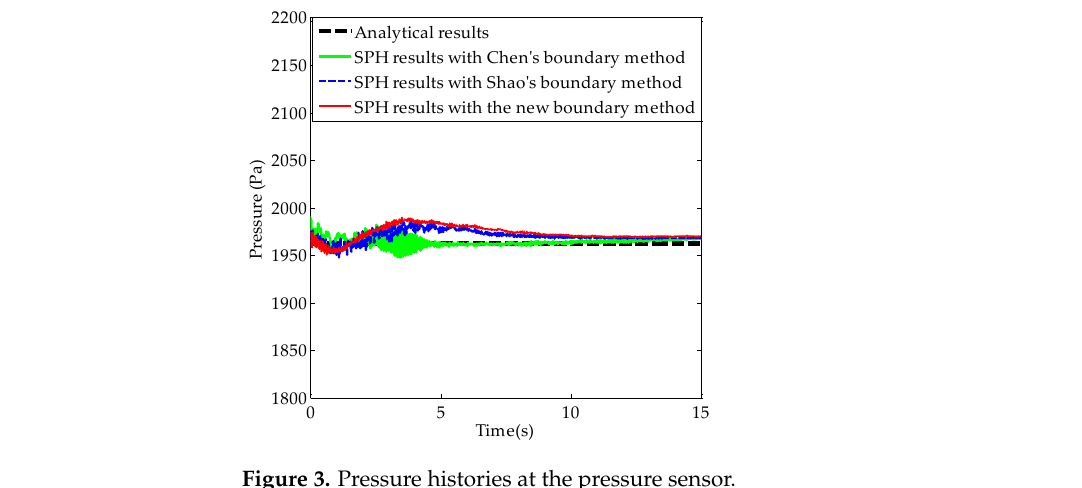
Figure 3. Pressure histories at the pressure sensor.